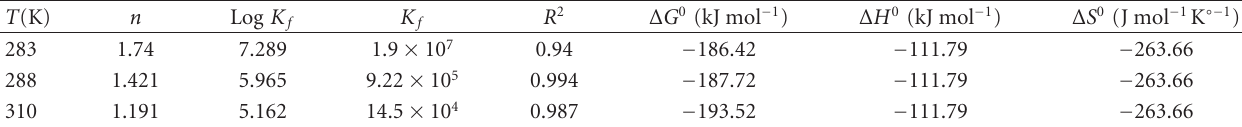
Table 3: Binding constants ( K f ), number of binding sites ( n ), and thermodynamic parameters of the Pt (II)-DNA system.